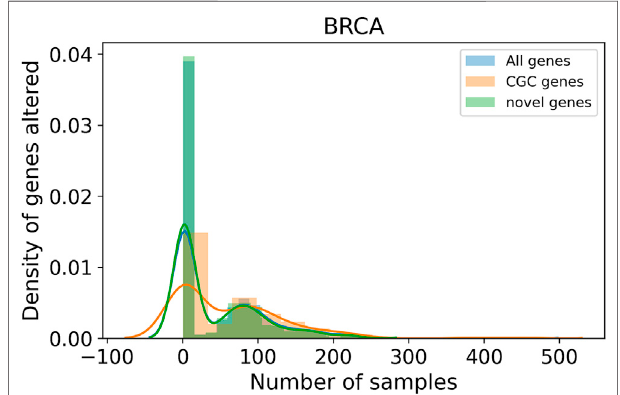
FIGURE 5 | Distribution of samples for genes predicted as a driver. The x -axis represents the number of BRCA samples a gene is identi fi ed as driver. The y -axis shows the density of genes identi fi ed in n samples. The plot shows a bi-modal distribution with genes mutated in many samples as well as < 20